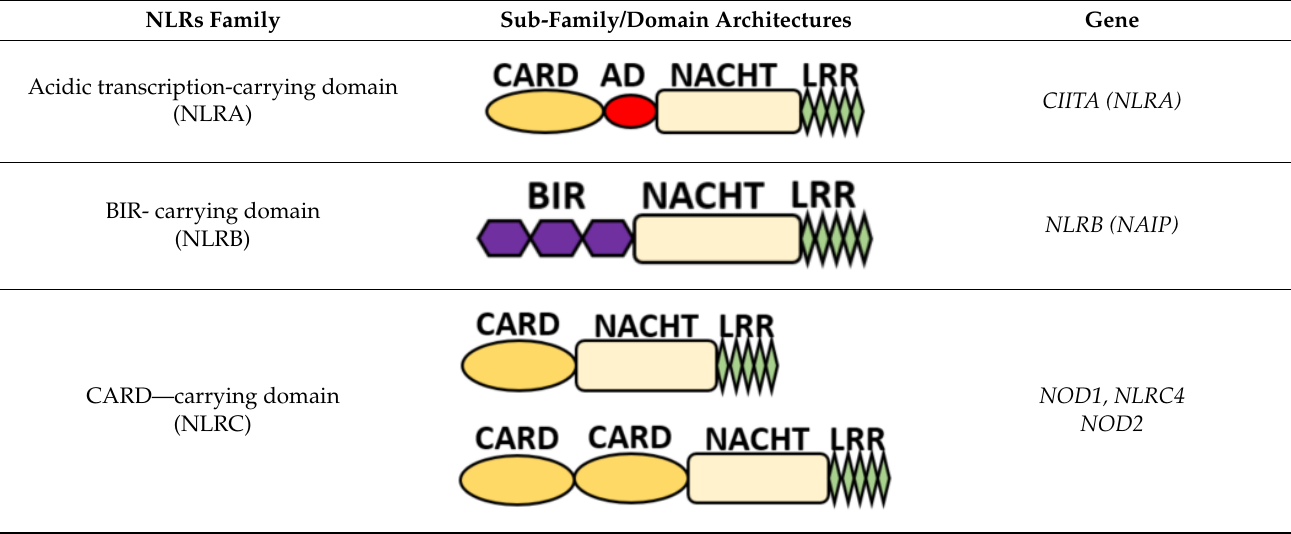
Table 2. Structure and classification of NLRs family.